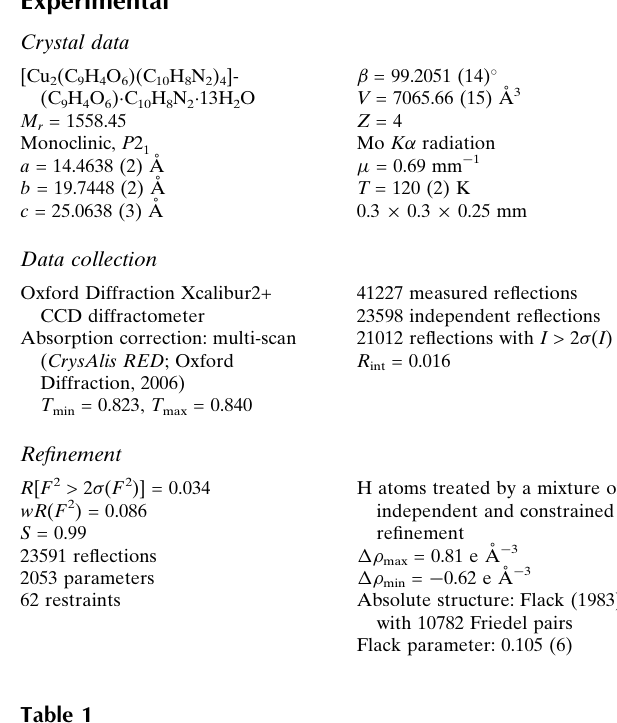
Key indicators: single-crystal X-ray study; T = 120 K; mean (cid:1) (C–C) = 0.005 A˚; H- atom completeness 96%; disorder in solvent or counterion; R factor = 0.035; wR factor = 0.086; data-to-parameter ratio = 11.5. The asymmetric unit of the title complex, [Cu formula units. The two Cu II centres are bridged by a 5- carboxybenzene-1,3-dicarboxylate (Hbtc) ligand. Each of the metal centres is bonded to four N atoms of two bidentate 2,2 0 - bipyridine ligands (bpy) and one O atom of the Hbtc ligand in a highly distorted square-pyramidal geometry. The secondary structure is stabilized by a variety of O—H (cid:1) (cid:1) (cid:1) O hydrogen bonds and (cid:2) – (cid:2) stacking interactions connecting the complex cations, Hbtc anions, bpy and water molecules of crystal- lization. Three water molecules are disordered over two positions, with site occupancy factors of ca 0.8 and 0.2.